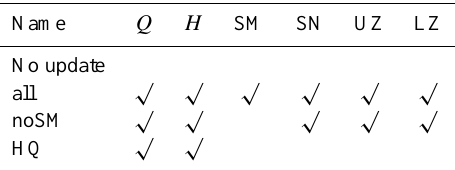
Table 2. Four partitioned state updating schemes (indicated in the first column) for five model states (indicated in the first row) being updated and thus included in the model analysis. Model states are described in Sect. 2.1 and Fig. 3 and have the follow- ing acronyms: discharge ( Q ), water level ( H ), soil moisture stor- age (SM), snow storage (SN), upper zone storage (UZ), and lower zone storage (LZ).